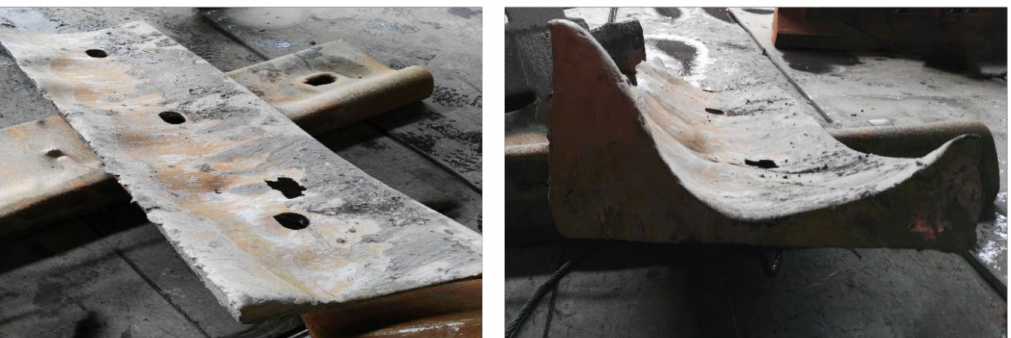
Figure 2. Worn liner.